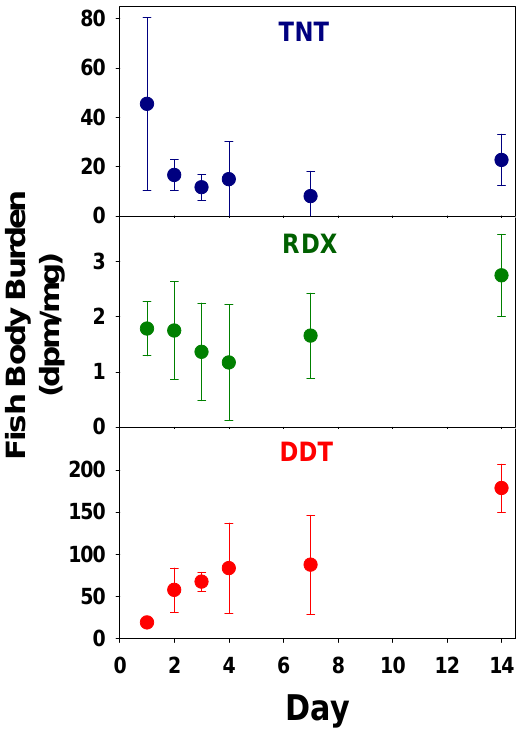
Figure 1: Body burden expressed as radioactivity (disintegrations per minute) per milligram of mass representing the total concentration (as parent compound equivalents) of the parent compound (TNT, RDX or DDT) and all its degradation products at different time points during the 14-day dietary exposure